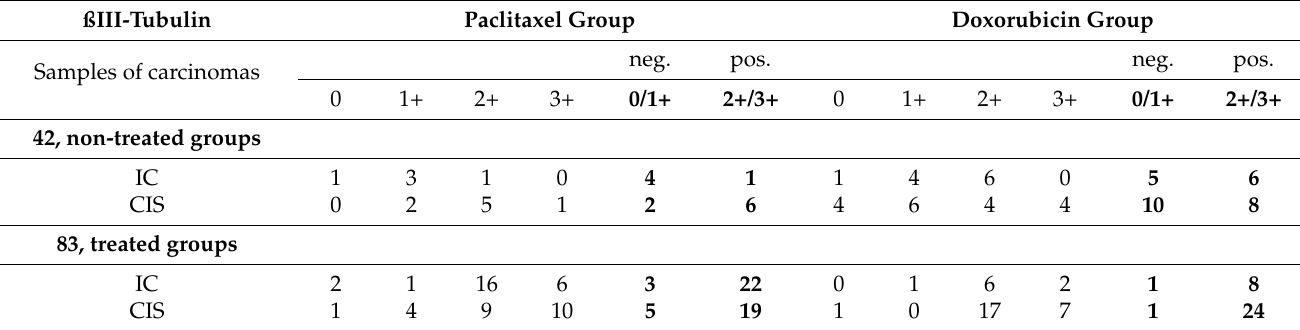
Table 1. Expression of ßIII-tubulin in invasive carcinoma (IC) and carcinoma in situ (CIS) tumor samples from non-treated and treated groups of female